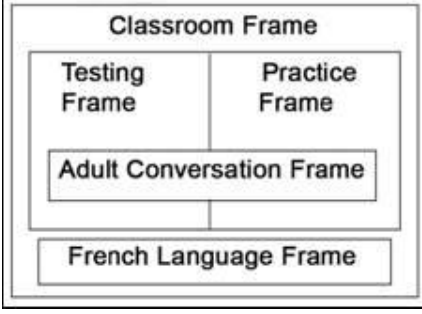
Interactive Frames Operating in a Beginning French Class for